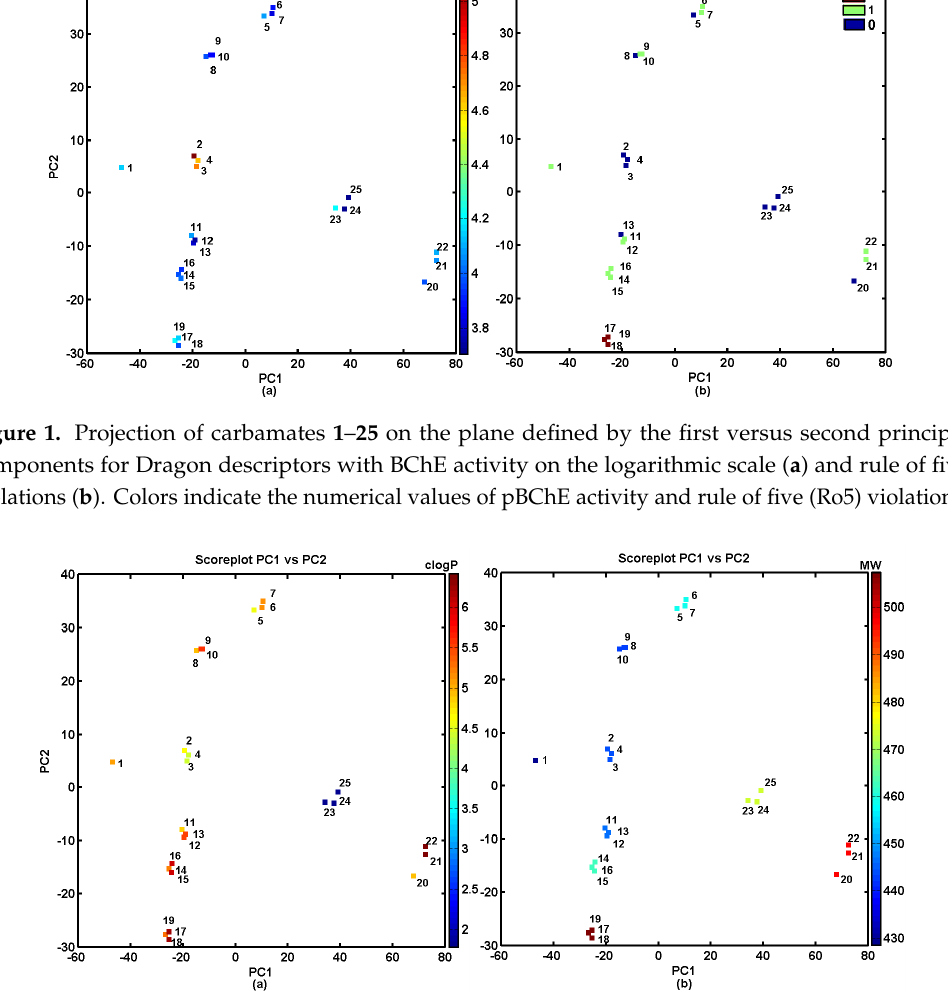
Figure 2. Projection of carbamates 1 – 25 on plane defined by the first versus second principal components for Dragon descriptors with calculated lipophilicity clogP ( a ) and molecular weights MW ( b ). Colors indicate the numerical values of clogP and MW.